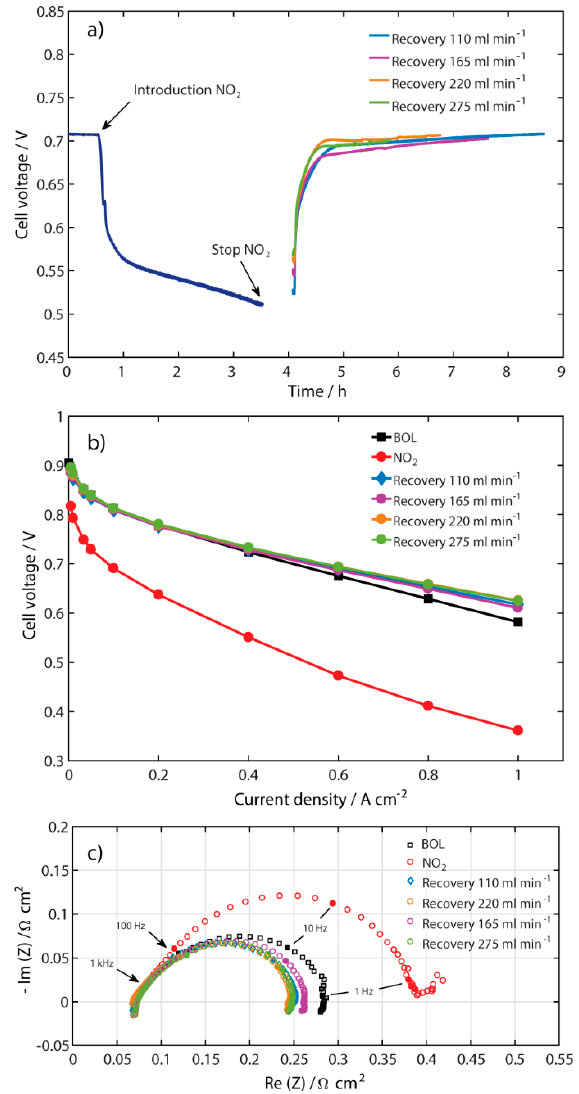
Figure 2. ( a ) Performance with 100 ppm NO 2 and after recovery at different airflows 110, 165, 220, and 275 mL min − 1 at 0.5 A cm − 2 ; ( b ) polarization curves; and ( c ) galvanostatic EIS measurements at 0.5 A cm − 2 for the same conditions as in ( a ).